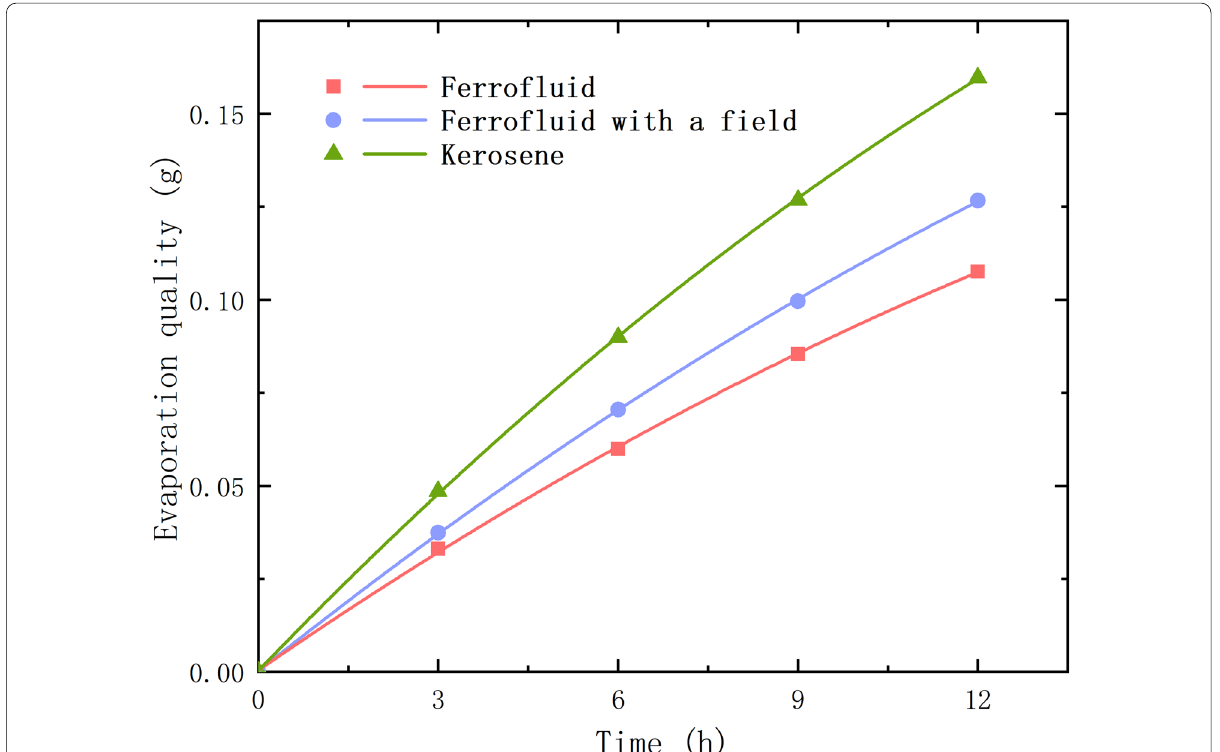
Figure 10 Weight loss of samples and their fitted curves with and without a magnetic